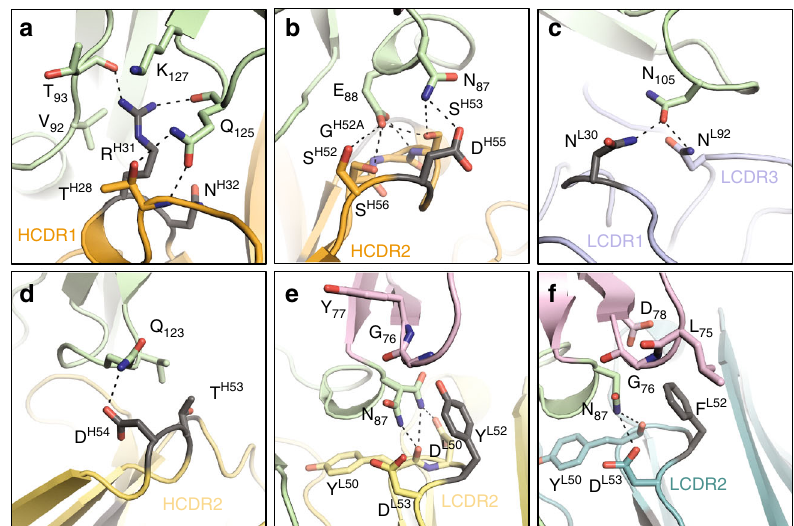
Fig. 6 Af fi nity maturation of mAbs at the binding interface. Somatic hypermutations (SHMs) that introduce new contacts with Pfs25 are colored dark gray. a A S31R mutation in the HCDR1 of 1269 introduces two H-bonds with Pfs25 residues T93 and Q125. b A G55D mutation in the HCDR2 of 1269 introduces an additional H-bond with Pfs25 residue N87. c A S30N mutation in the LCDR1 of 1262 leads to an additional H-bond with Pfs25 residue N105. d A S54D mutation in the HCDR2 of 1190 leads to an additional H-bond contact with Pfs25 residue Q123. e A S52Y mutation in the LCDR2 of 1190 leads to additional van der Waals interactions with Pfs25 residues, and ensures that N87 hydrogen bonds with adjacent LCDR2 residues. f Similar to 1190, 1276 has a S52F mutation in the LCDR2 that leads to additional van der Waals contacts with Pfs25 residues, and ensures that N87 hydrogen bonds with adjacent LCDR2